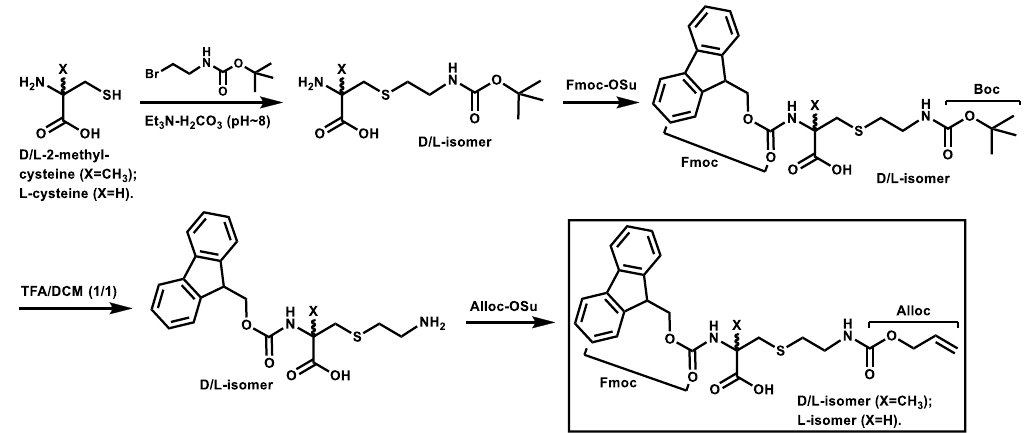
Scheme 1. Synthesis of the Fmoc,Alloc-diprotected D -/ L -  -methyl-thialysines and the Fmoc,Alloc-diprotected L-thialysine.